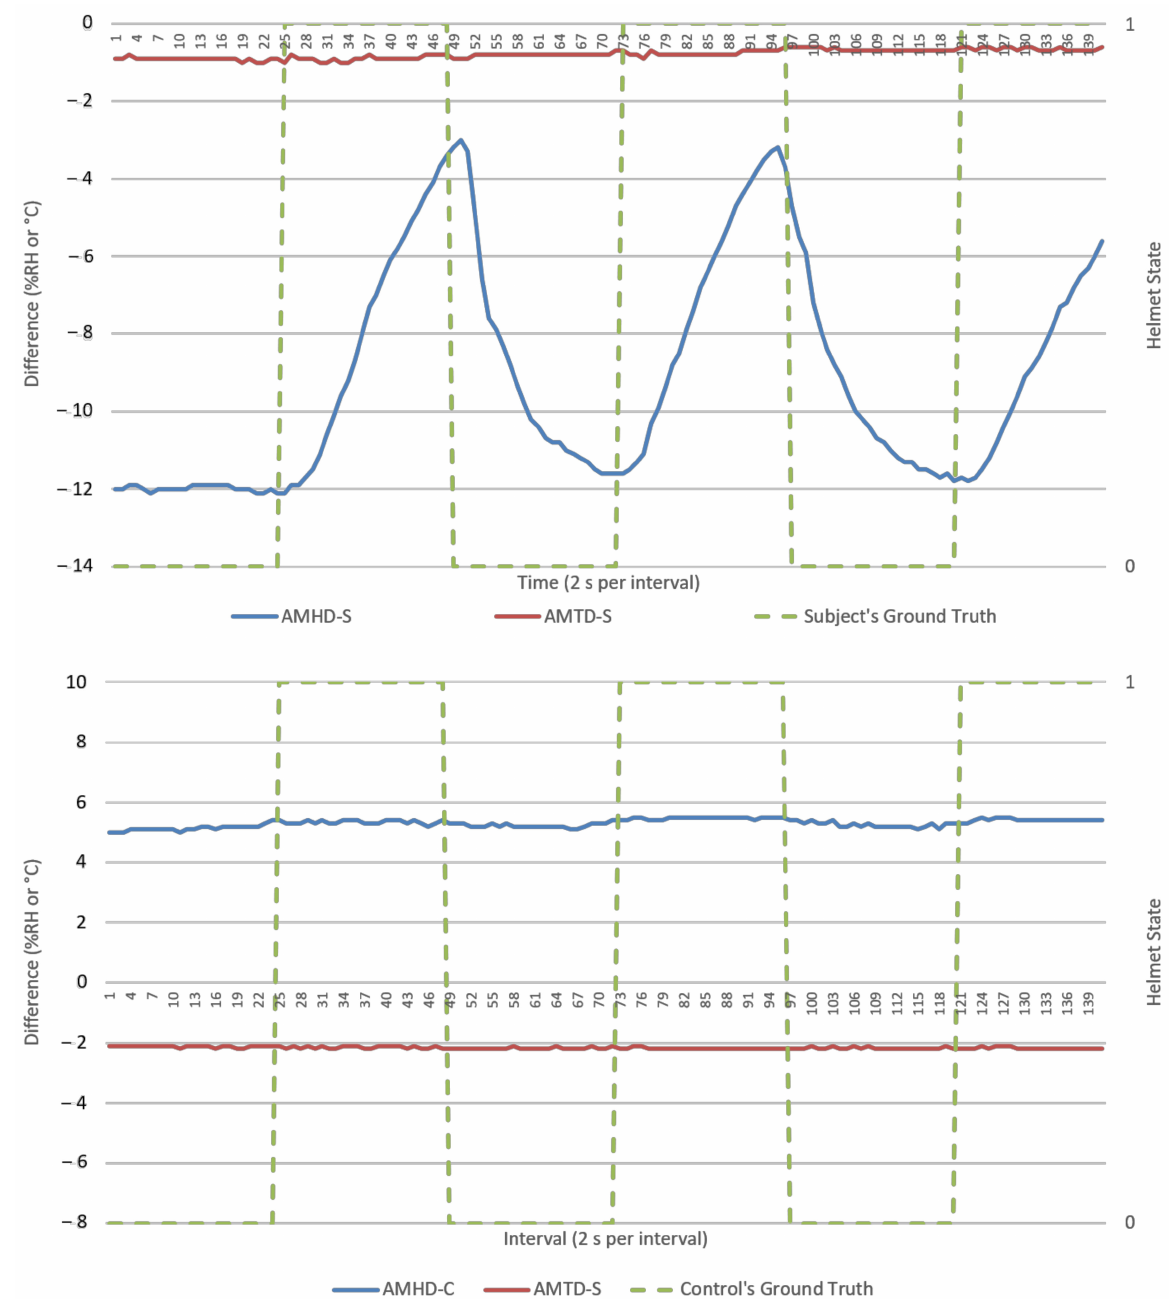
Figure 10. AMDs versus time (2 s per interval) from a typical M run, human subject ( top ), and experiment control ( bottom ). Helmet state 0 = NW and 1 =